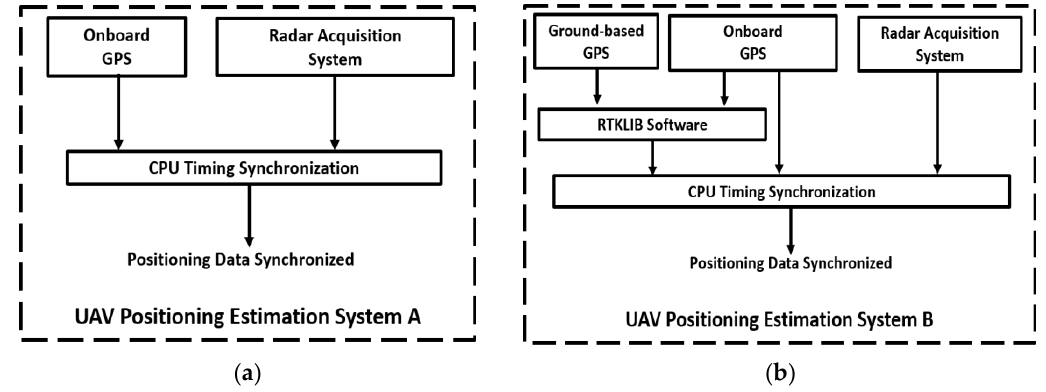
Figure 2. Positioning and radar data synchronization strategy ( a ) Standalone GPS; ( b ) Carrier based Differential Global Positioning System (CDGPS).